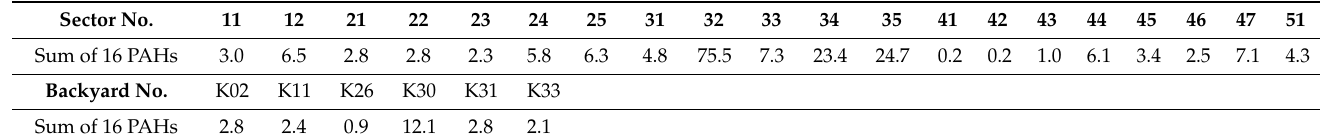
Table 8. The sum of 16 PAHs in sectors and backyards